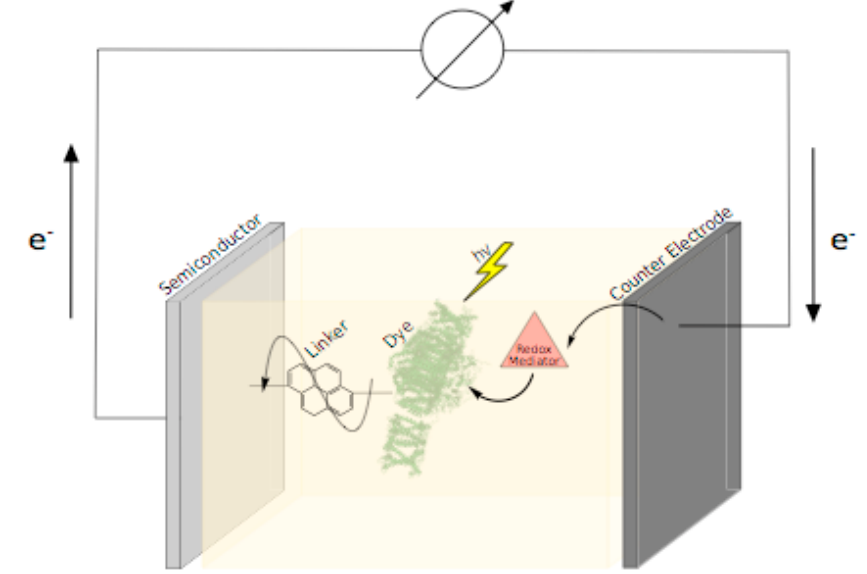
Figure 1. General schematic showing the key working components of a biohybrid photoelectrosynthetic cell. The figure shows a bio-absorber (dye), after light excitation donating an electron through a linker to a semiconductor surface. This electron is then passed to the counter electrode where it interacts with a redox mediator that reduces the oxidized bio-absorber and completes the circuit.